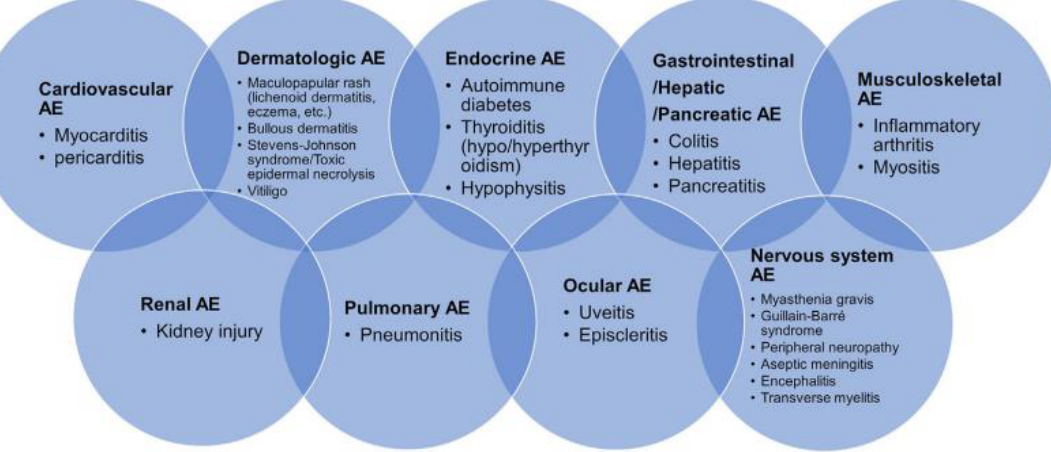
Figure 3. Immune-related adverse events (irAEs) in various organs. National Comprehensive Cancer Network notices irAEs in multiple organs.